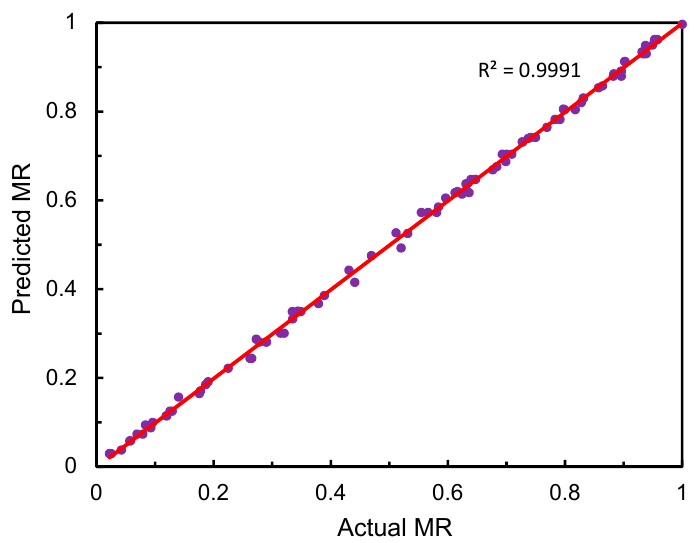
Figure 9. The predicted vs. actual MR for testing datasets.